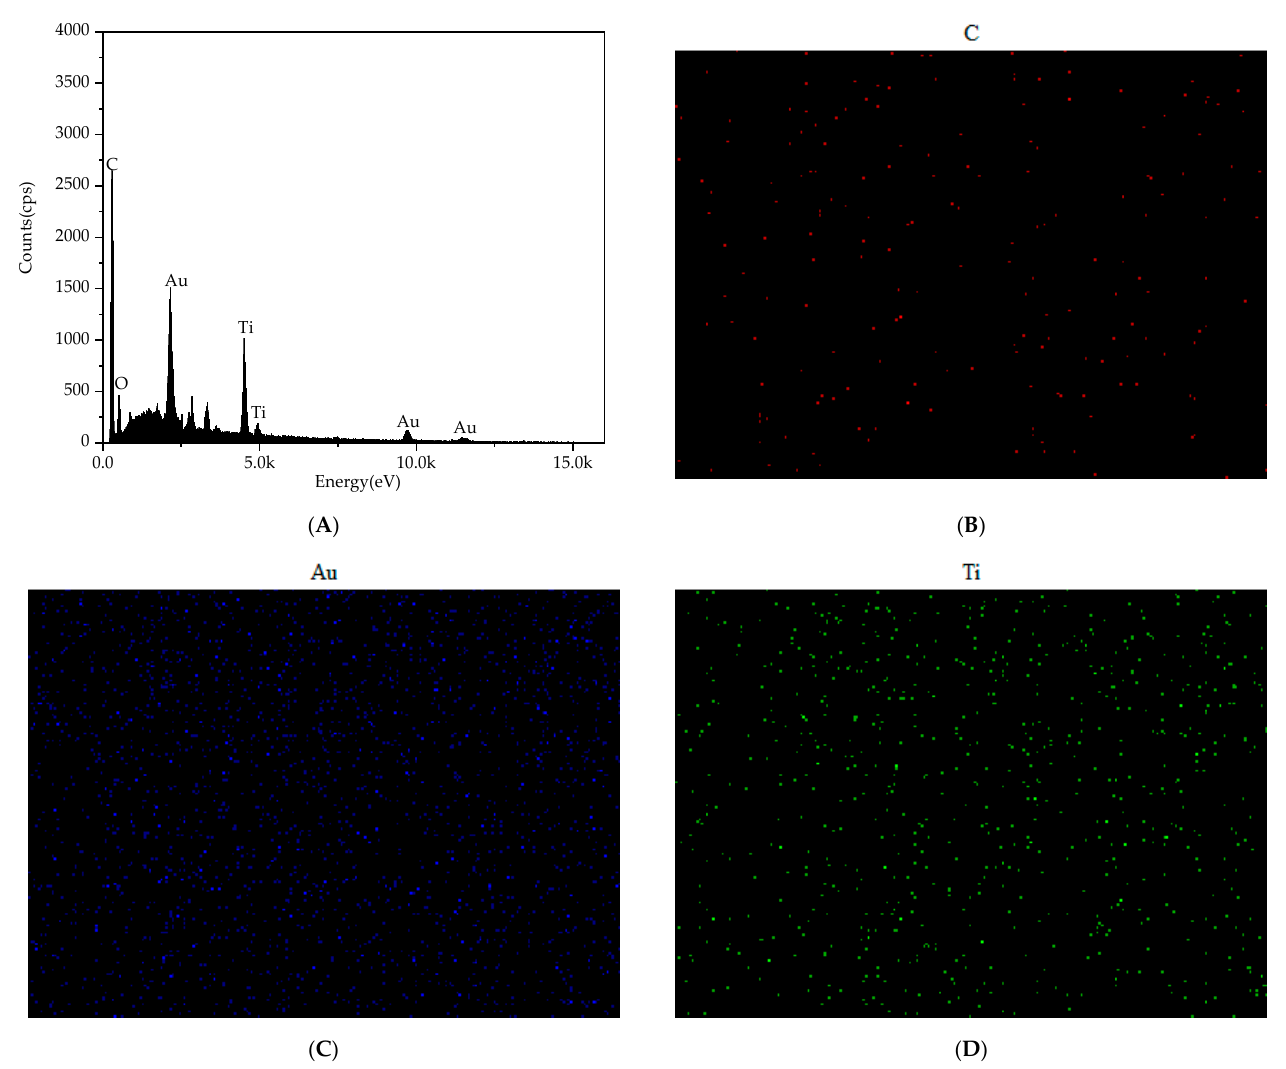
Figure 2. The energy-dispersive X-ray spectroscopy (EDS) ( A ) and element mapping of AuNPs/MXene/ERGO, ( B ) C. ( C ) Au and ( D ) Ti.